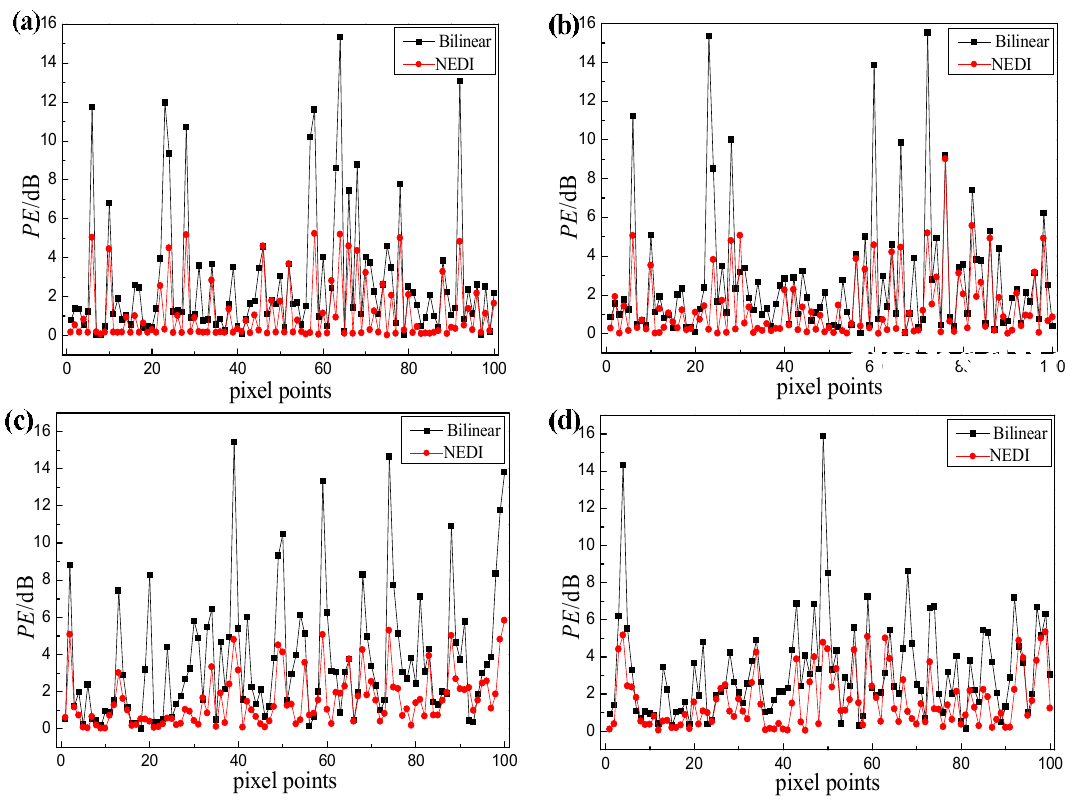
Figure 10. Pixel error analysis of centergrid of different holes ( a ) hole 5; ( b ) hole 7; ( c ) hole 9; ( d ) hole 11.